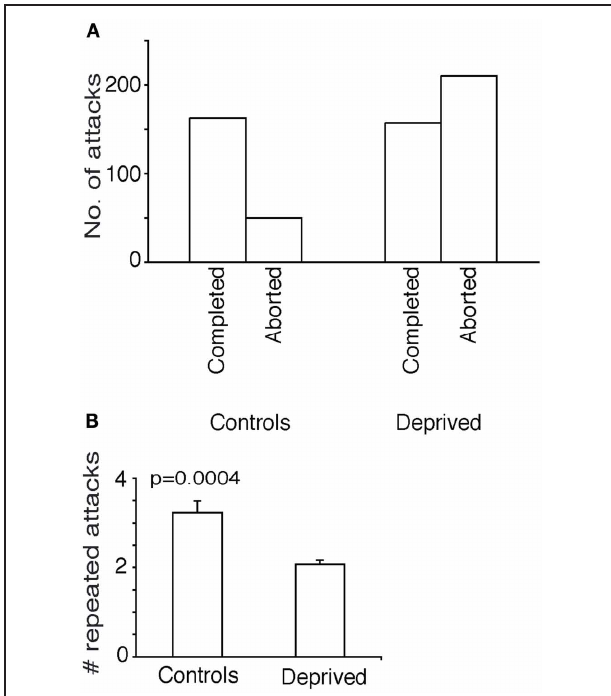
FIGURE 4 | Further attack characteristics in whisker deprived animals. (A) Counts of aborted and completed attacks/success rate. In controls only 32% of attacks were aborted. In whisker-deprived animals 57% of attacks were aborted. (B) Repeated attacks. Control animals attacked the same cricket repeatedly more often than the deprived animals.